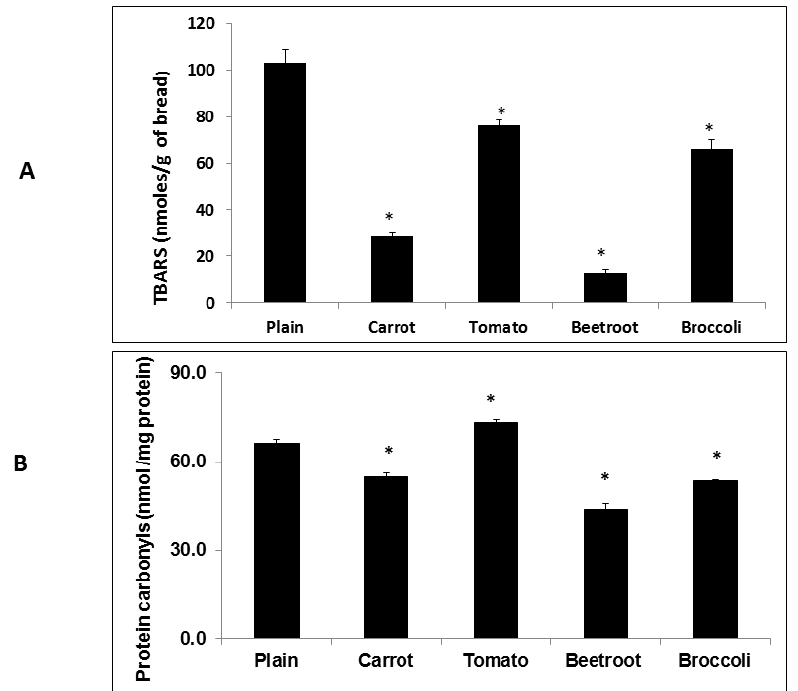
Figure 3. Thiobarbituric acid reactive substances (TBARS) ( A ) and Protein Carbonyl (PC) ( B ) contents in the fresh breads. Treatments with asterisks are significantly different to the plain bread ( p < 0.05). Values are means ± SE ( n = 3).